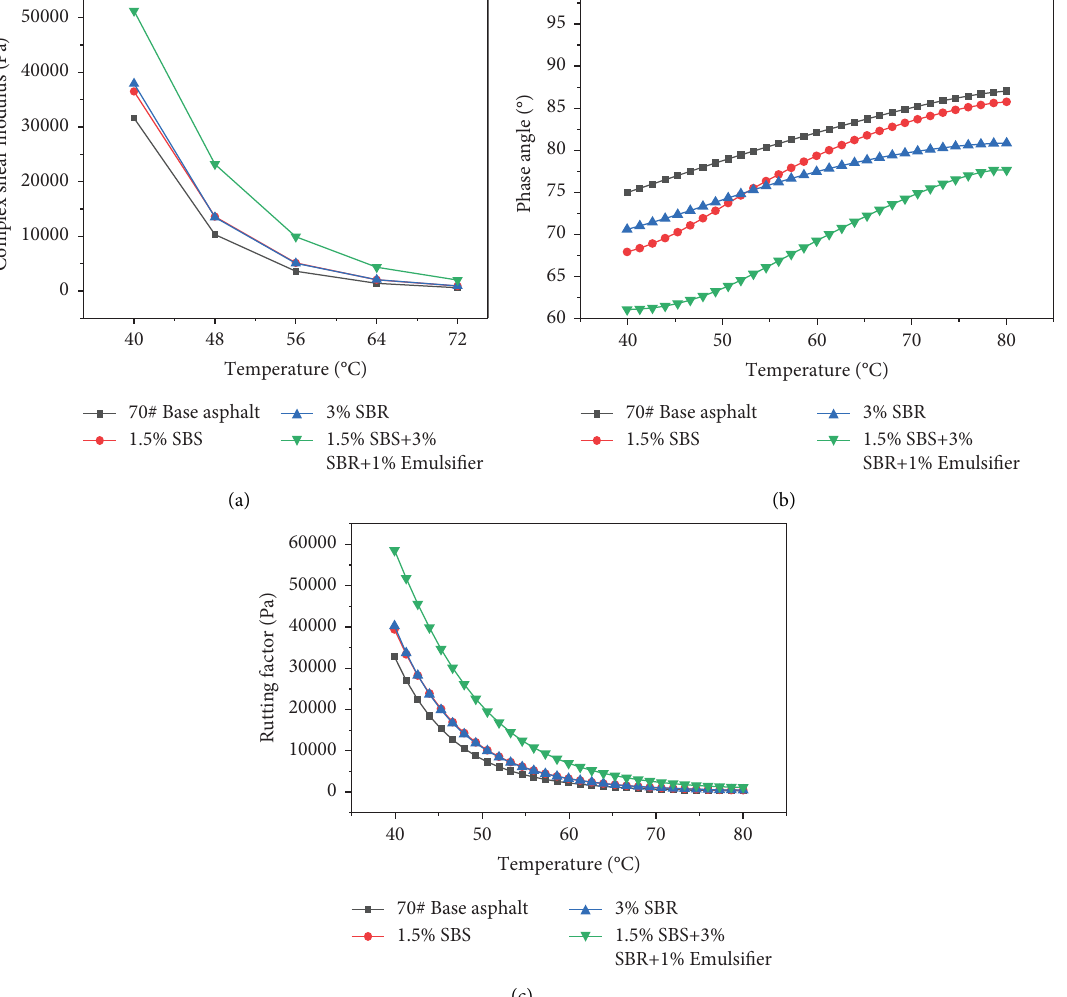
Figure 7: DSR temperature sweep results for four types of emulsifed asphalt. (a) Variation of complex shear modulus with temperature for four types of emulsifed asphalt. (b) Variation of phase angle with temperature for four types of emulsifed asphalt. (c) Variation of rutting factor with temperature for four types of emulsifed